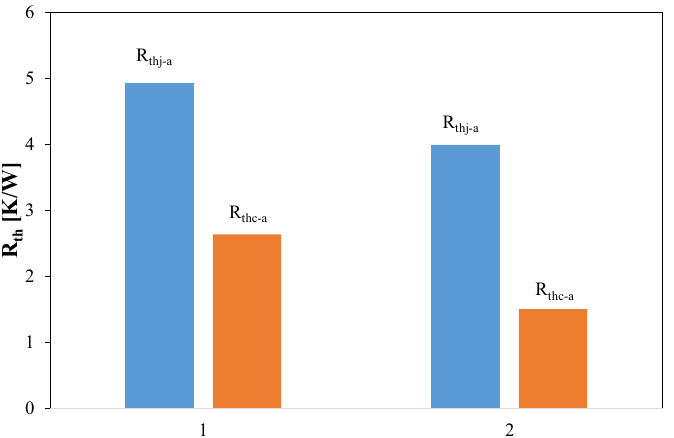
Figure 10. Measured waveforms of transient thermal impedance of the tested transistor mounted on the heat exchanger.